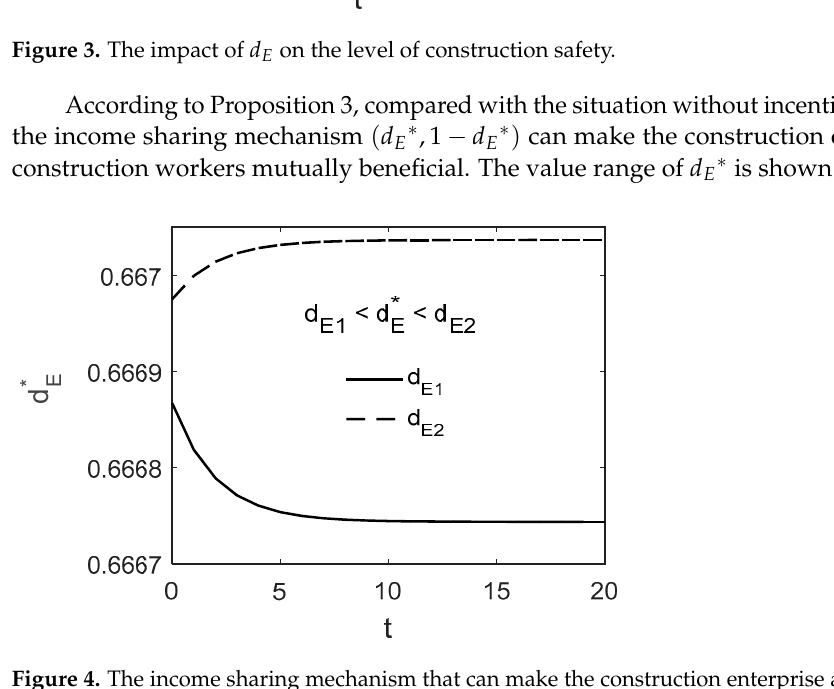
Figure 4. The income sharing mechanism that can make the construction enterprise and construction workers mutually beneficial.